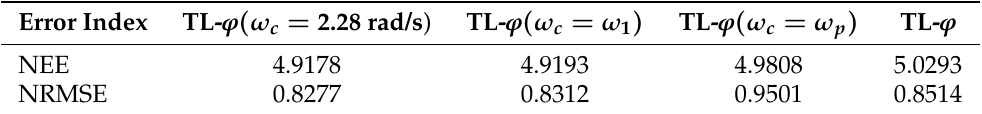
Table 15. Displacement errors for the 4th